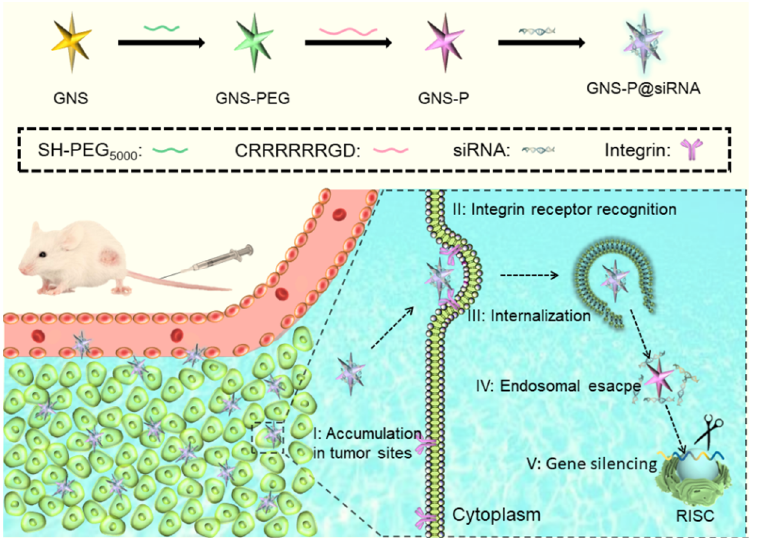
Figure 1. Schematic diagram of the antitumor process of GNS-P as the siRNA delivery